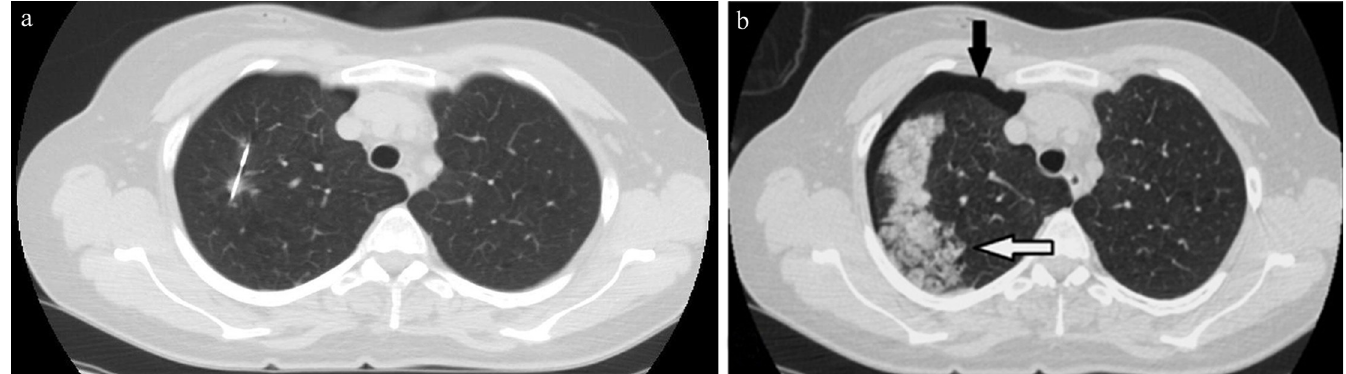
Fig 1. Complications of CT-guided lung biopsy. (a) CT-guided lung biopsy with a non-coaxial semi-automated 18 gauge biopsy system of a 9mm right upper lobe nodule which was proved to be bronchogenic carcinoma at pathologic examination. (b) Post-biopsy CT image showed complications in the form of a small pneumothorax 1cm (black arrow), and a new ground-glass opacity along needle tract measuring > 2cm in width but sublobar corresponding to grade 2 pulmonary hemorrhage (white arrow).